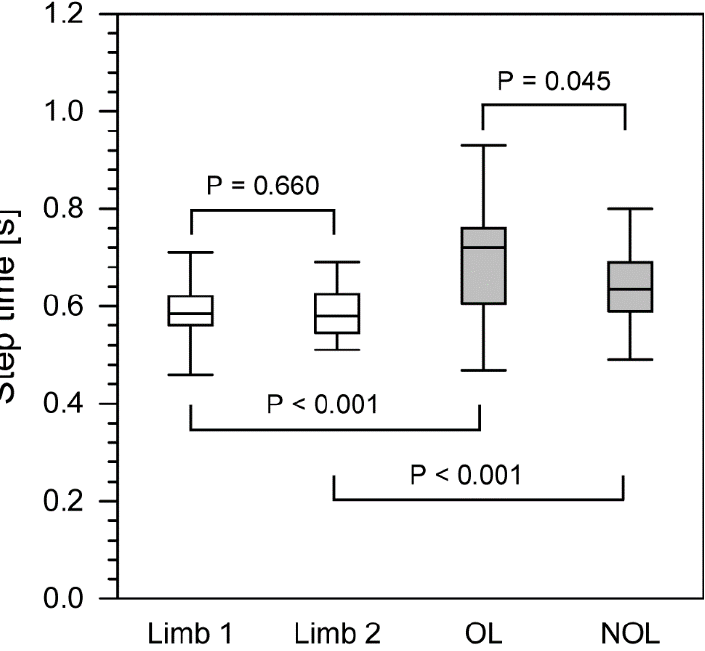
Figure 3. The comparison of step length between healthy group and patients after treatment with the Ilizarov method. The boundary of the box closest to zero indicates the 25th percentile, a line within the box marks the median, and the boundary of the box farthest from zero indicates the 75th percentile. Whiskers above and below the box indicate the 90th and 10th percentiles. White boxes, healthy people; filled boxes, patients. OL, operated limb; NOL, non-operated limb.